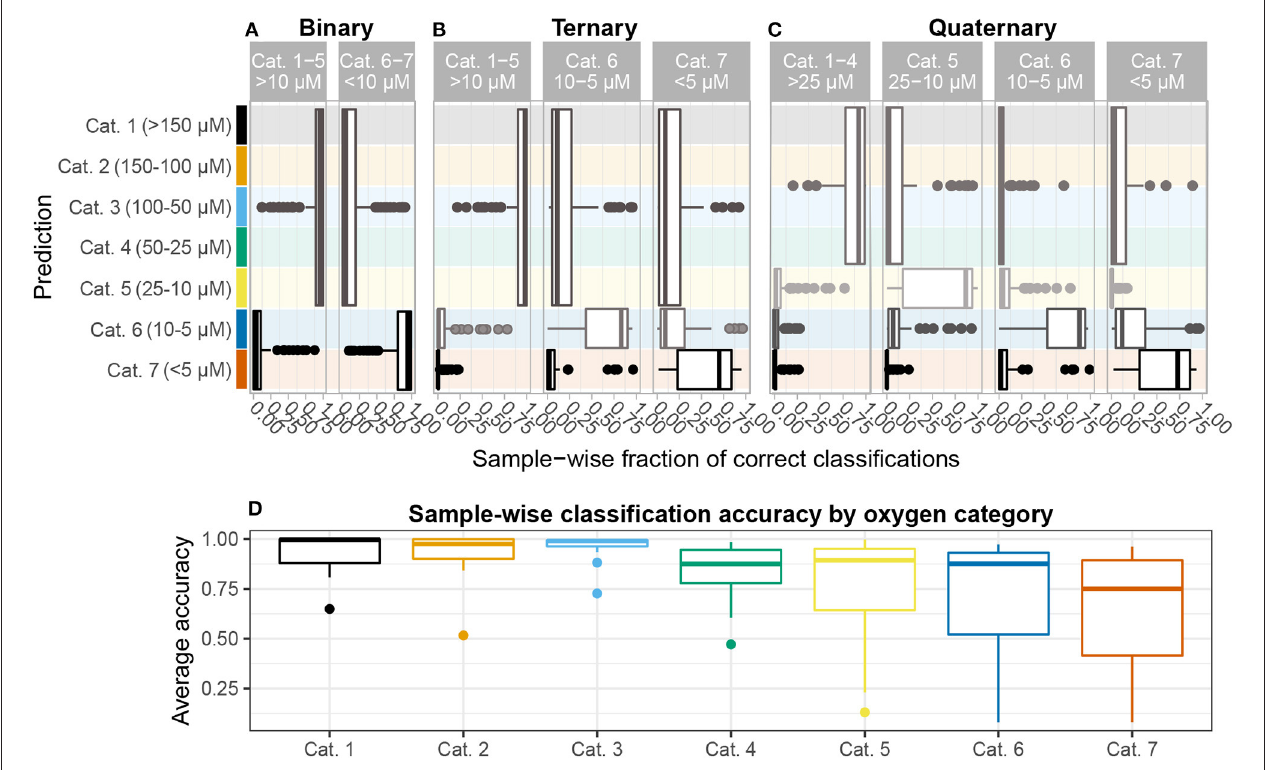
FIGURE 4 | Sample-wise accuracy. All analyses report average accuracy over n = 128 iterations. Results are shown for (A) binary, (B) ternary, and (C) quaternary classification problems. The height of each box denotes the oxygen categories comprising each group in the classification problem. In the ternary and quaternary classification problems, median accuracy tends to decrease as oxygen depletes. (D) The average accuracy for each sample over all three classification problems shown on (A–C) are grouped by oxygen category. A higher fraction of samples with oxygen concentration > 25 µ M, corresponding to categories 1–4, are classified correctly than 5–7, all of which suffer from a tail of seldom-correctly classified samples, indicating that communities inhabiting sediments with < 25 µ M oxygen concentration are comparatively more heterogeneous and, therefore, harder to delineate